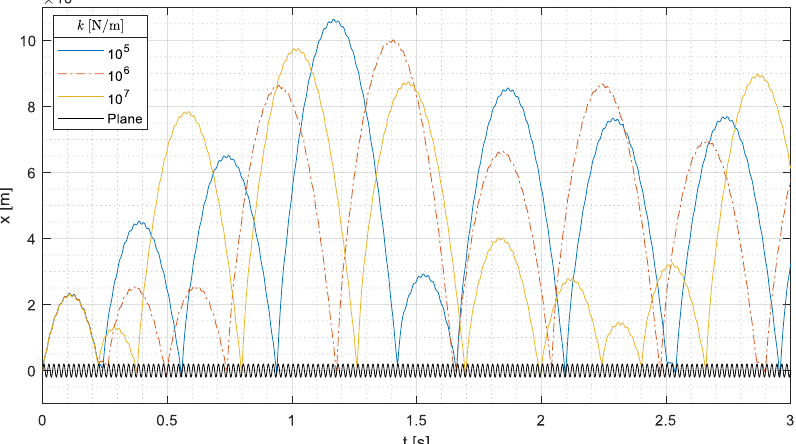
Figure 13. Numerical results, displacement of the cylindrical part along the track, 𝜃 = 3° , 𝜓 = 0 , 𝑓 𝑣 = 0.005 𝜇 𝑐 = 0.3, 𝜇 𝑠 = 0.6 , and parametric values of contact stiffness.